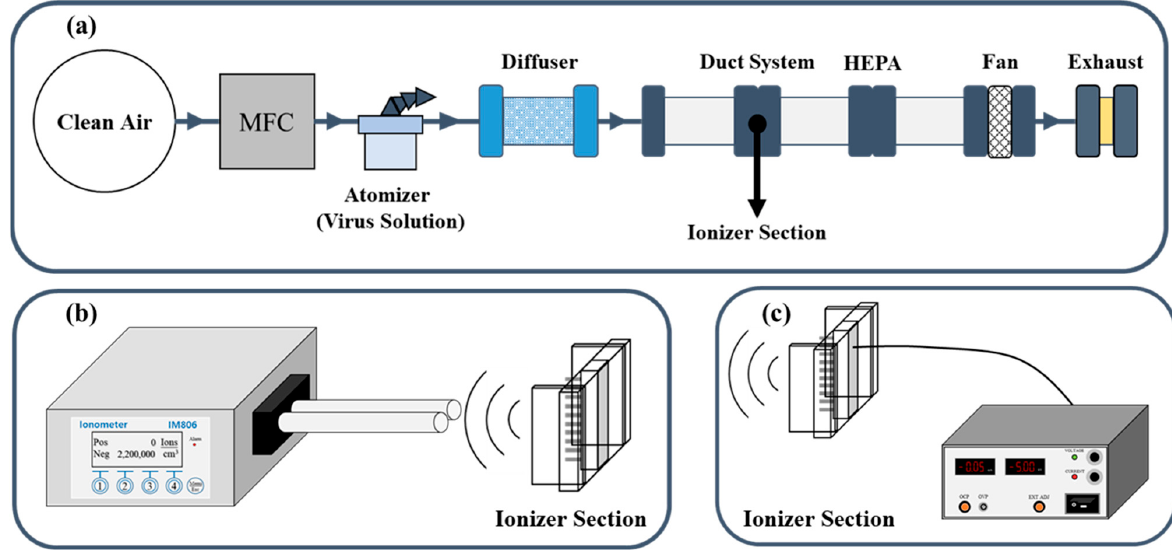
Figure 1. Duct system used for the measurements. ( a ) Duct system for the virus spread; ( b ) Measuring device setup for the ion measurement of the ionizers in the ducts; ( c ) Experimental concept to connect the ionizer and the voltage generator in the duct.